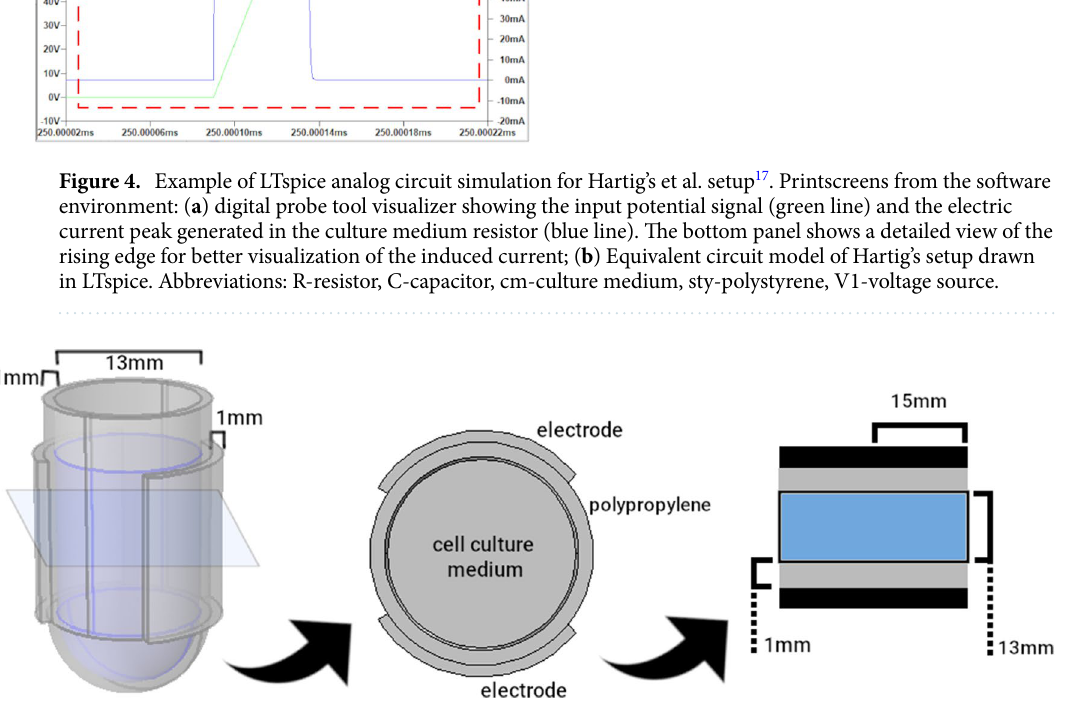
Figure 5. 3D FE model created to replicate Rodan’s et al. setup 7 and the geometrical approximation considered for its equivalent electronic circuit